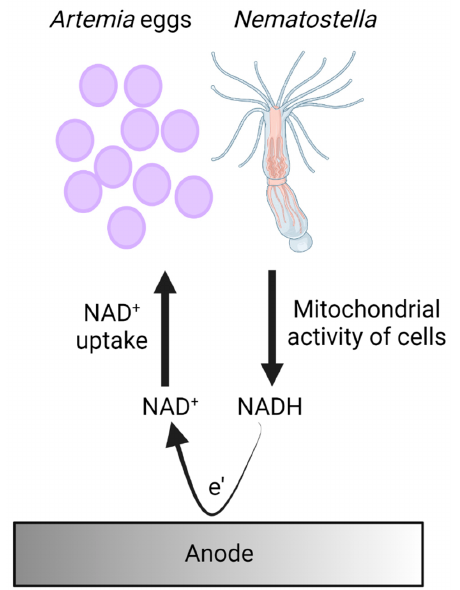
Figure 5. A proposed mechanism for electron transfer in bio-electrochemical cells based on Nematostella and Artemia’s eggs. Cells of Nematostella and Artemia’s eggs produce NADH by their mitochondrial activity. Upon association with the anode, some of the NADH molecules are released by the organisms and donate electrons at the anode to produce an electrical current.